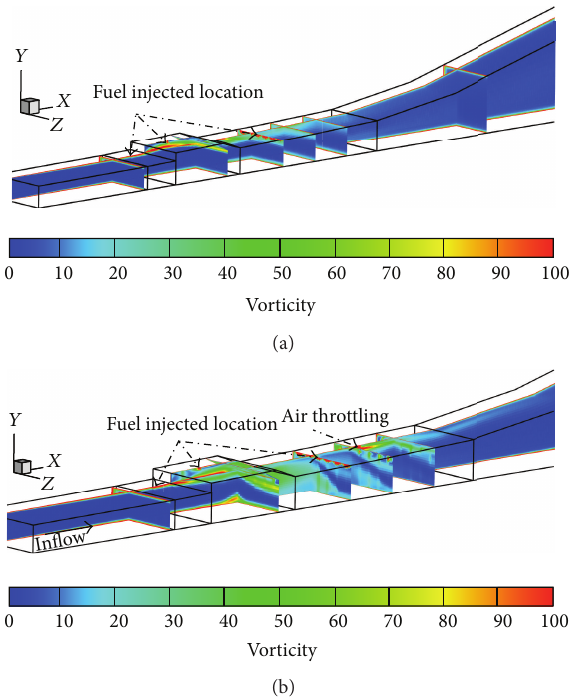
Figure 6: Vorticity magnitude contours of the scramjet combustor with and without air throttling ((a) case without air throttling; (b) case with air throttling).